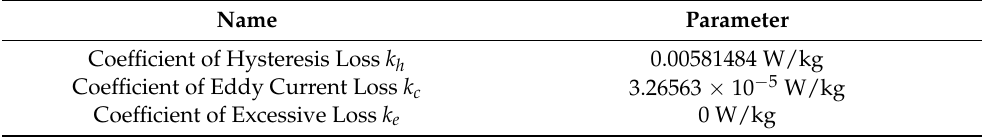
Table 3. Loss coefficients of the iron core (@60 Hz).